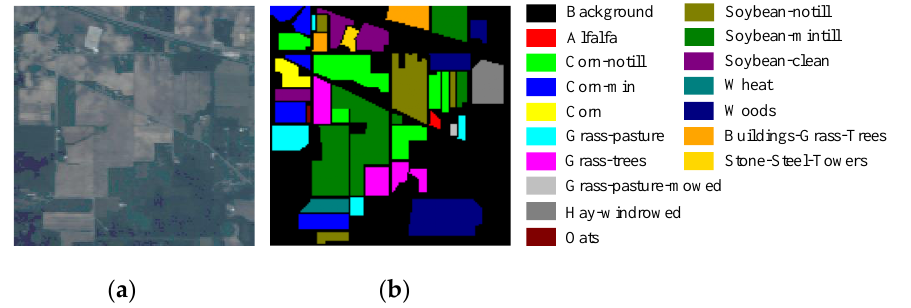
Figure 6. Indian Pines dataset: ( a ) false color map, ( b ) ground truth. Table 1. Land cover classes and numbers of samples in the Indian Pines dataset.